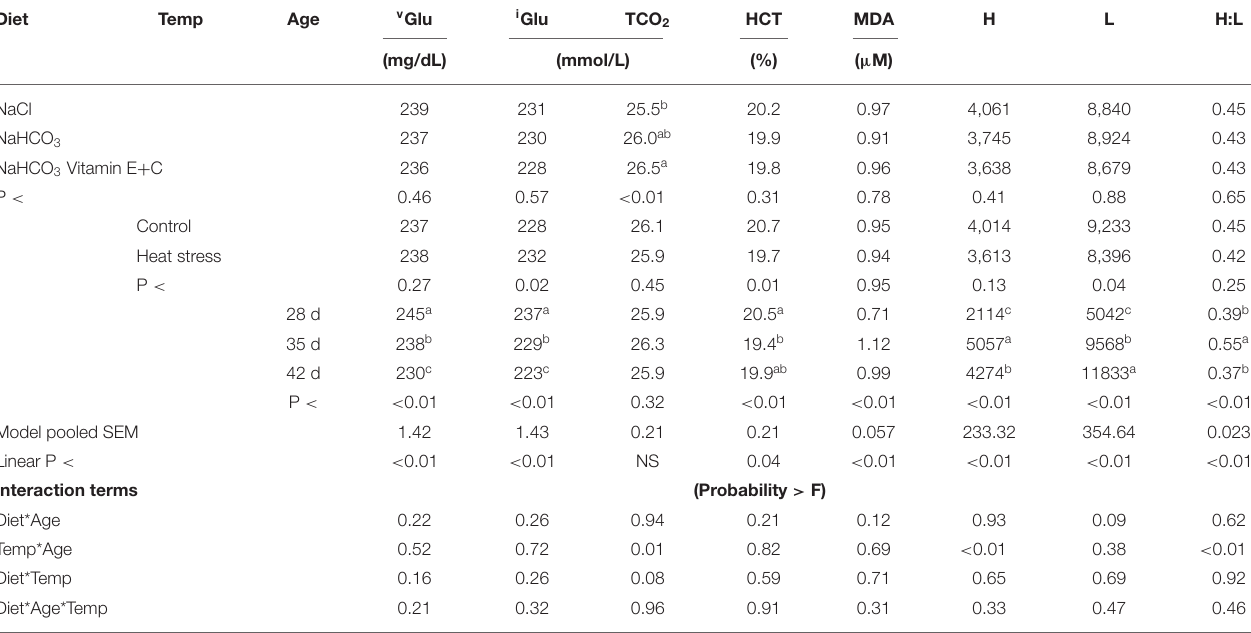
TABLE 5 | Effect of diet and temperature and age on blood protein composition and other metabolites over time. Diet Temp